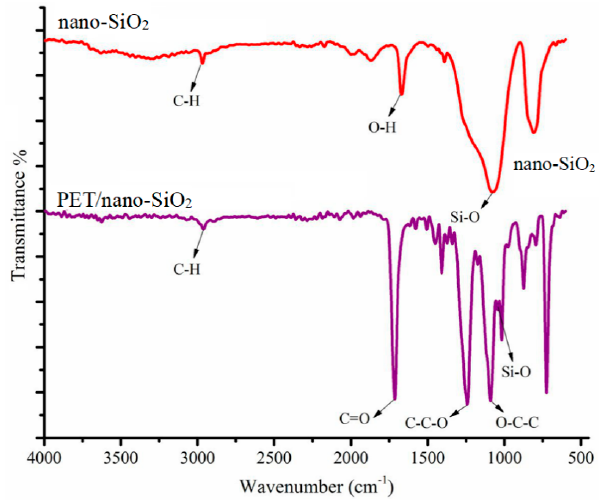
Figure 3. The FT-IR spectra of electrospun nano-SiO 2 and PET/nano-SiO 2 .